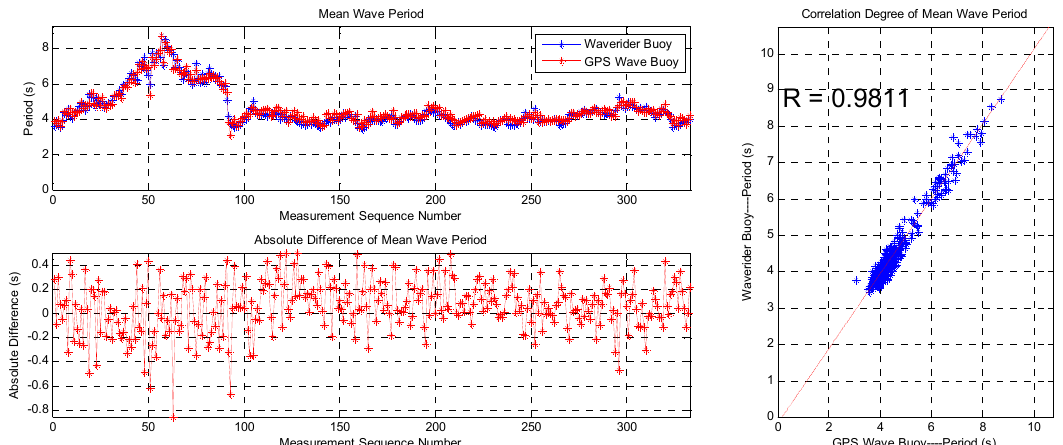
Figure 16. Comparison of mean wave periods between the SBF7-1A GPS wave buoy and the DWR-MKIII Waverider buoy after correction.